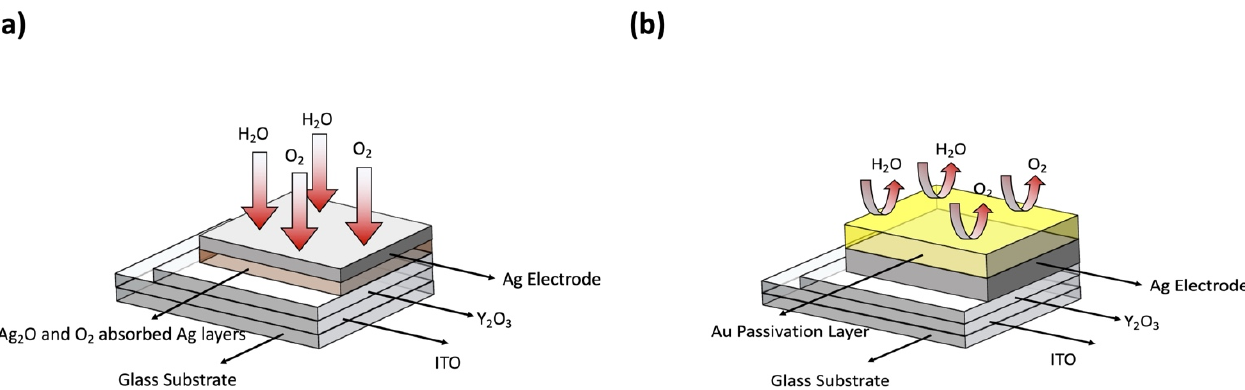
Figure 5. Extracted performance parameters of the fabricated Y 2 O 3 RRAM devices with Ag and Au-passivated Ag top electrodes: ( a ) SET voltage, ( b ) RESET voltage, ( c ) LRS, and ( d ) HRS. The dots are outliners which are located outside the whiskers of the box plot.